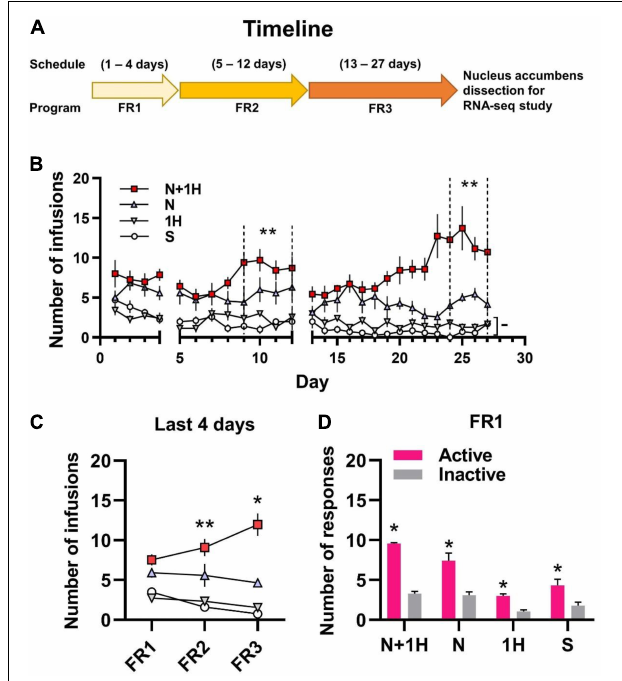
FIGURE 1 | Self-administration of smoking-related doses of nicotine and harmane in rats. (A) Timeline of 1 h/day self-administration. (B) Number of infusions in FR1-FR3 self-administration. White circle, saline group (S); gray inverted triangle, 1 µ g/kg/inf harmane group (1H); blue triangle, 30 µ g/kg/inf nicotine group (N); red square, 30 µ g/kg/inf nicotine + 1 µ g/kg/inf harmane group (N + 1H). The number of infusions in FR2-FR3 was significantly increased in the N + 1H group compared to the N group (** p < 0.01), while there was no significant difference from FR1 to FR3 in the H and S groups ( - p > 0.05). (C) Average infusions in the FR1-FR3 last 4 days in each group. The number of infusions increased significantly from FR1 to FR3 in the N + 1 group (** p < 0.01 from FR1 to FR2 and * p < 0.05 from FR2 to FR3), while other groups did not increase. (D) Histograms of the response data in FR1. Active responses were significantly higher in all groups than inactive responses (* p < 0.05). Data are presented in the figure using mean ±